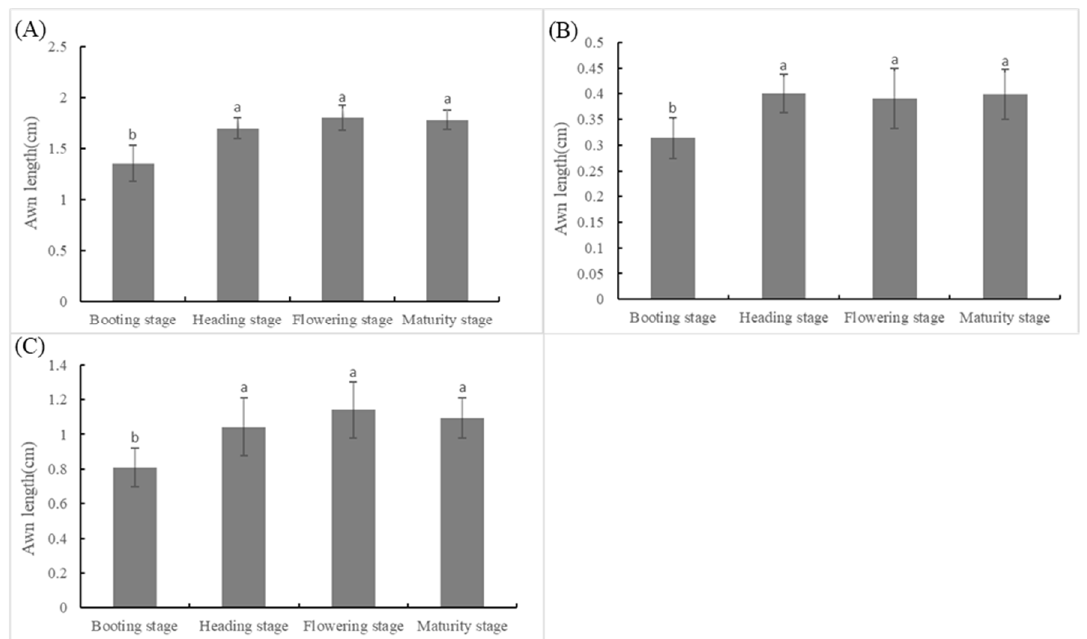
Figure 7. The difference of awn length of three accessions at developmental stages: ( A ) W610220, long awn, ( B ) PI 655186, medium awn, ( C ) PI 619592, short awn. Error bars represent mean ± standard deviation. Different normal letters mean significant difference among different treatments at 0.05 level.